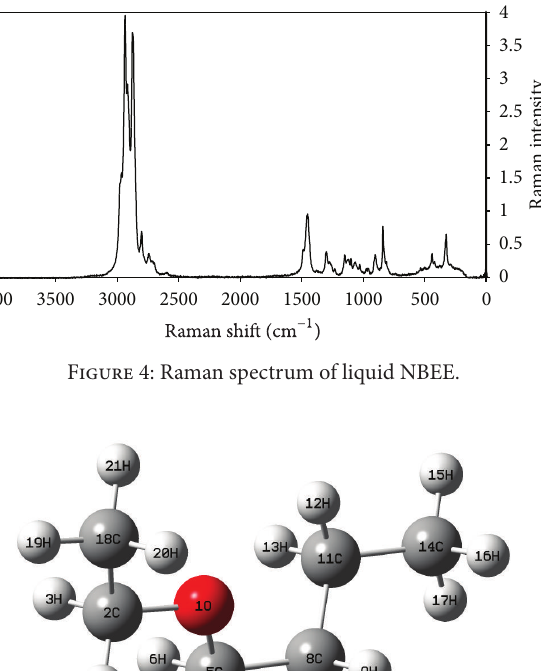
F 5: Atom numbering in the NBEE